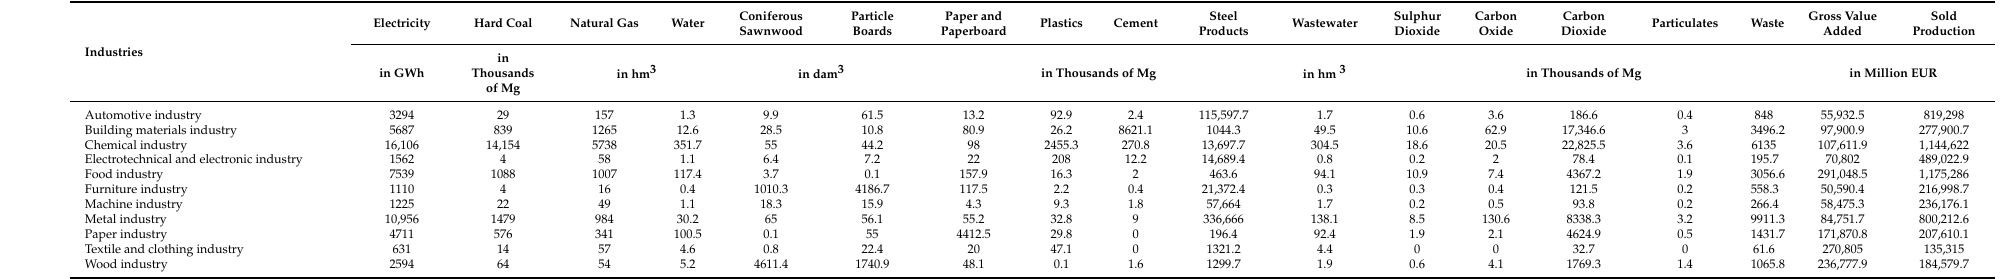
Table A1. Simplified LCI table of manufacturing in Poland (base year of 2019).